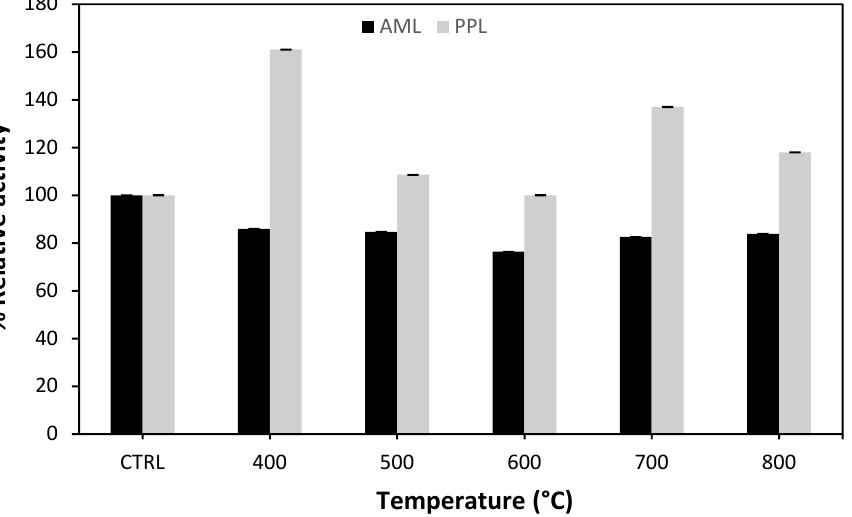
Figure 3. Effect of carbonization temperature of samples A1–A5 on the relative activity of two types of immobilized lipase, Amano lipase (AML) and porcine lipase (PPL), against the free li- pases.